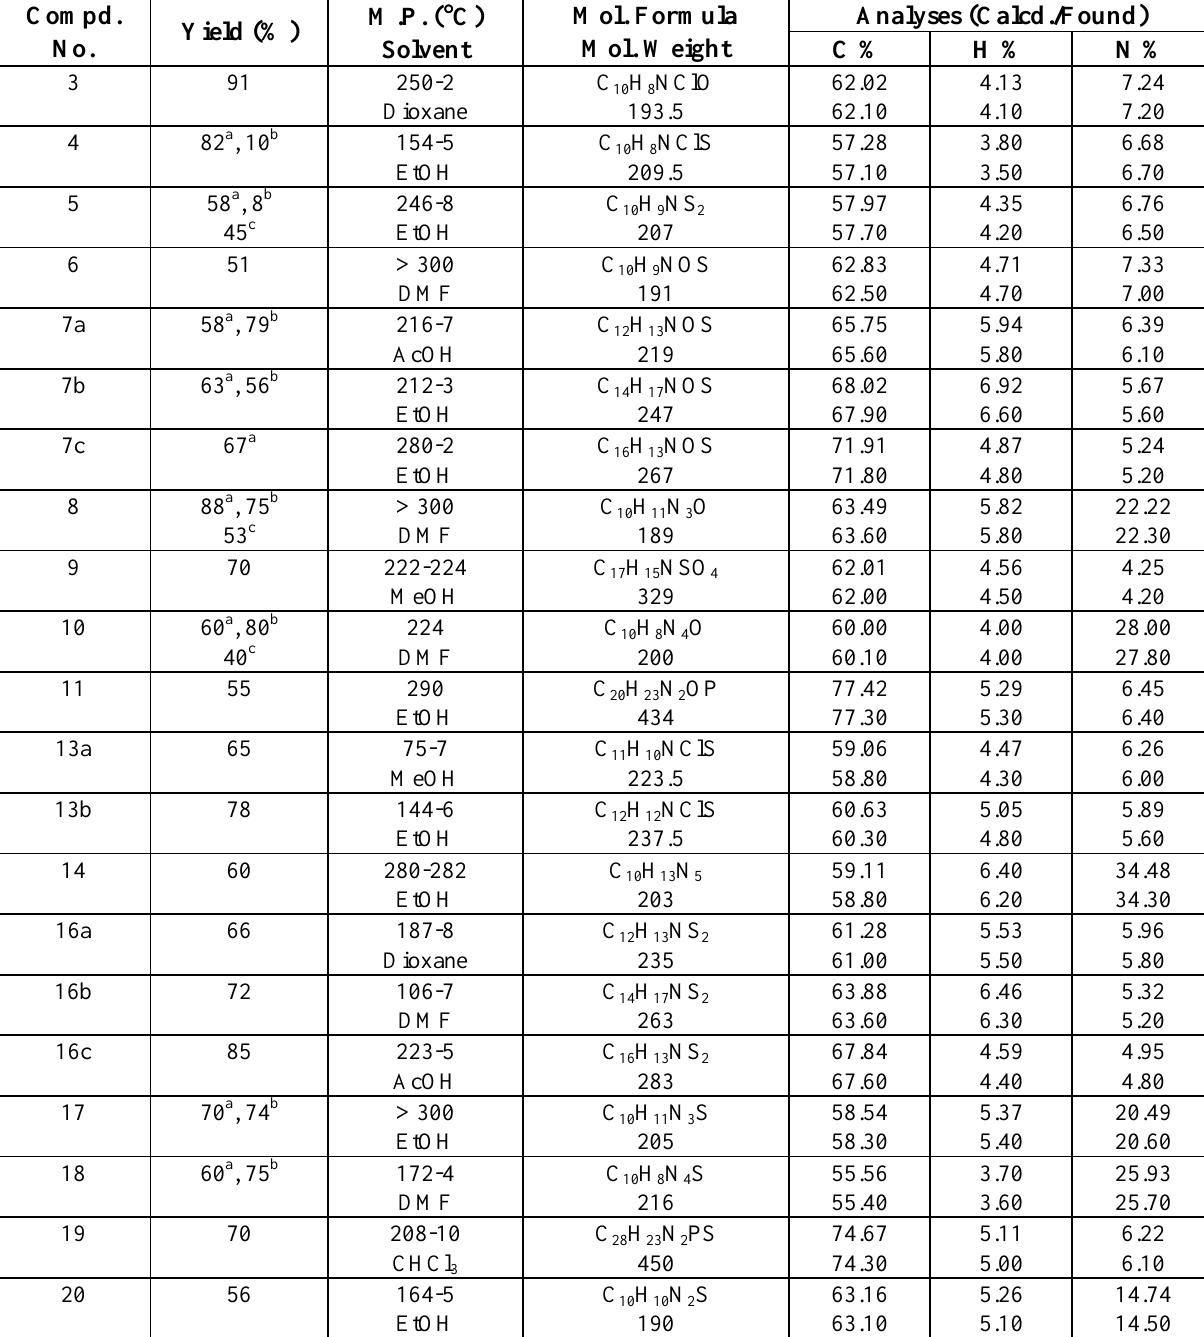
Table 1. Analytical data of the new compounds.